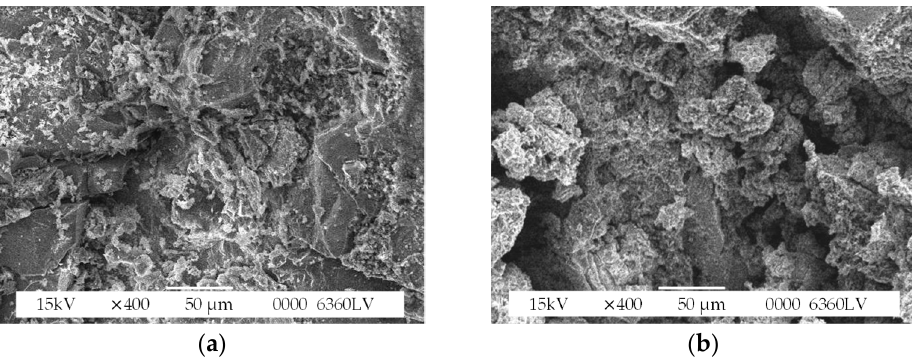
Figure 4. SEM images of EDM machined area of ( a ) Al adhesive foil and ( b ) Cu adhesive foil. (Peak current of 4 A, auxiliary current with high voltage of 1.2 A, pulse duration of 200 µs, electrode jumping-up time of 2 sec, and servo reference voltage of 40 V.)